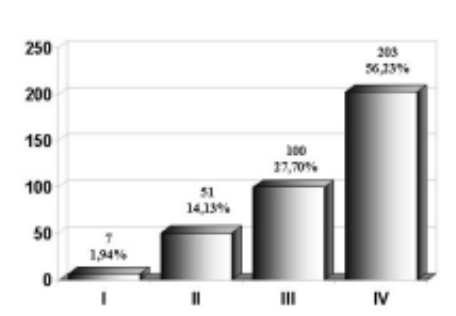
DIAS, AR ET AL - Surgical treatment of active infectious endocarditis: a study of 361 surgical cases